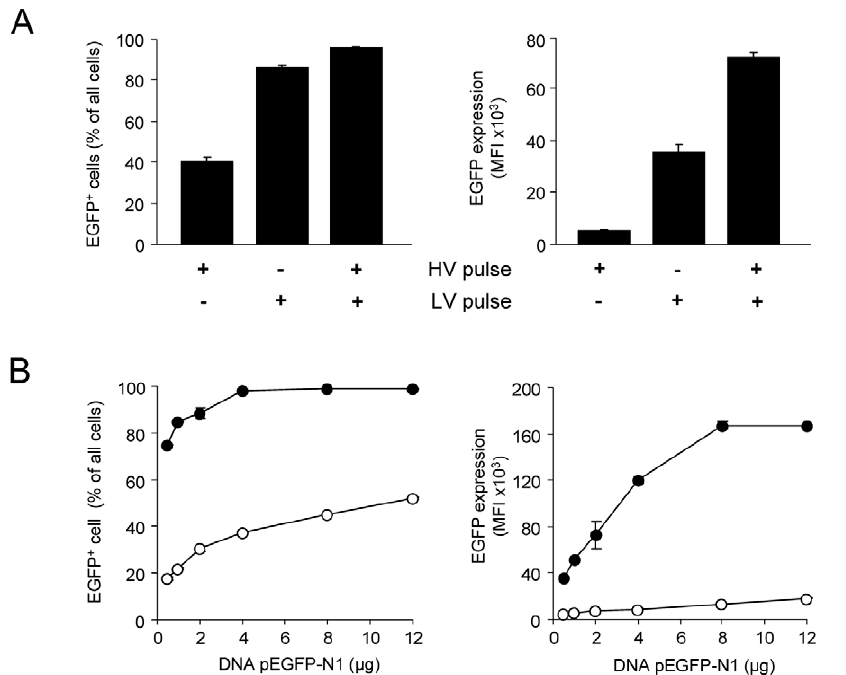
Figure 3. Impact of pulse composition and plasmid DNA amount on the transfection efficiency for primary murine preadipocytes. (A) 3T3L1 cells were transfected with 2 m g pEGFP-N1 using the ELPorator 1000 device for single HV or LV pulses or for a combined HV/LV pulse (HV: 3 kV/cm, 400 m s; LV: 1.5 kV/cm, 5 ms). Efficiency was estimated by flow cytometry from the percentages of EGFP + cells and from individual EGFP expression levels after 24 h. Mean values 6 SEM, n=2. (B) Primary murine preadipocytes were transfected with different amounts of pEGFP-N1